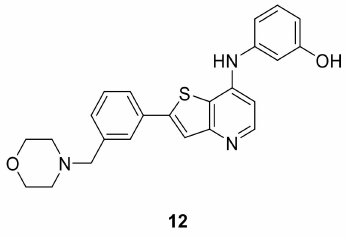
Figure 3. Chemical structure of compound 12